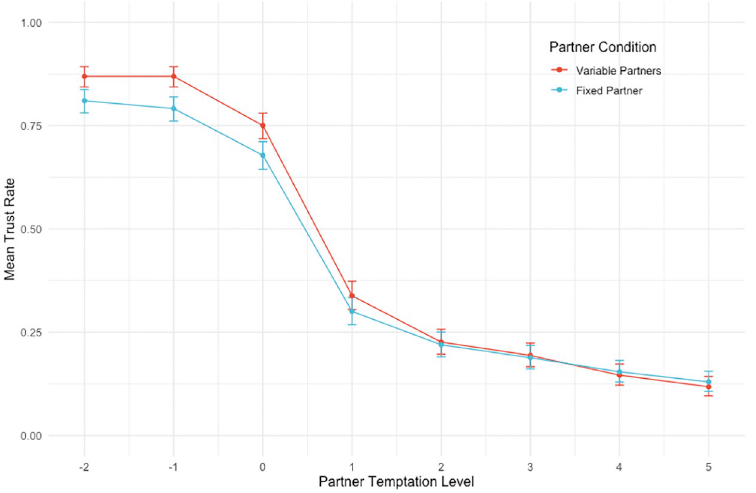
Fig 7. Experiment 2 data. Graphs show mean trust rates (proportion of trials in which participants chose the coordination option) by partner condition for the corresponding temptation level of partners’ alternative option. Points represent where data was collected, and error bars represent 95% confidence intervals calculated using binomial tests. Regression results (see Table 2) show that trust rates were significantly lower when participants coordinated with the same partner (Fixed Partner) on every trial than when coordinating with different partners (Variable Partners) on each trial. In addition, trust rates are significantly decreasing with increases in the level of partners’ temptation of the alternative